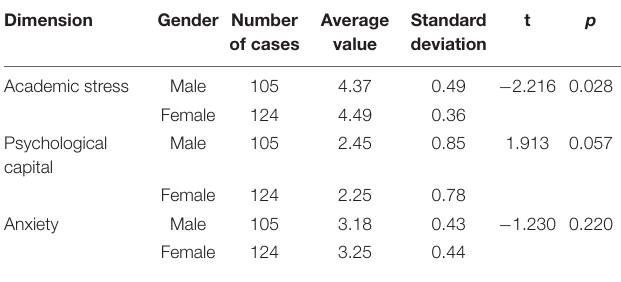
TABLE 4 | Difference test results of different genders on academic stress, psychological capital, and